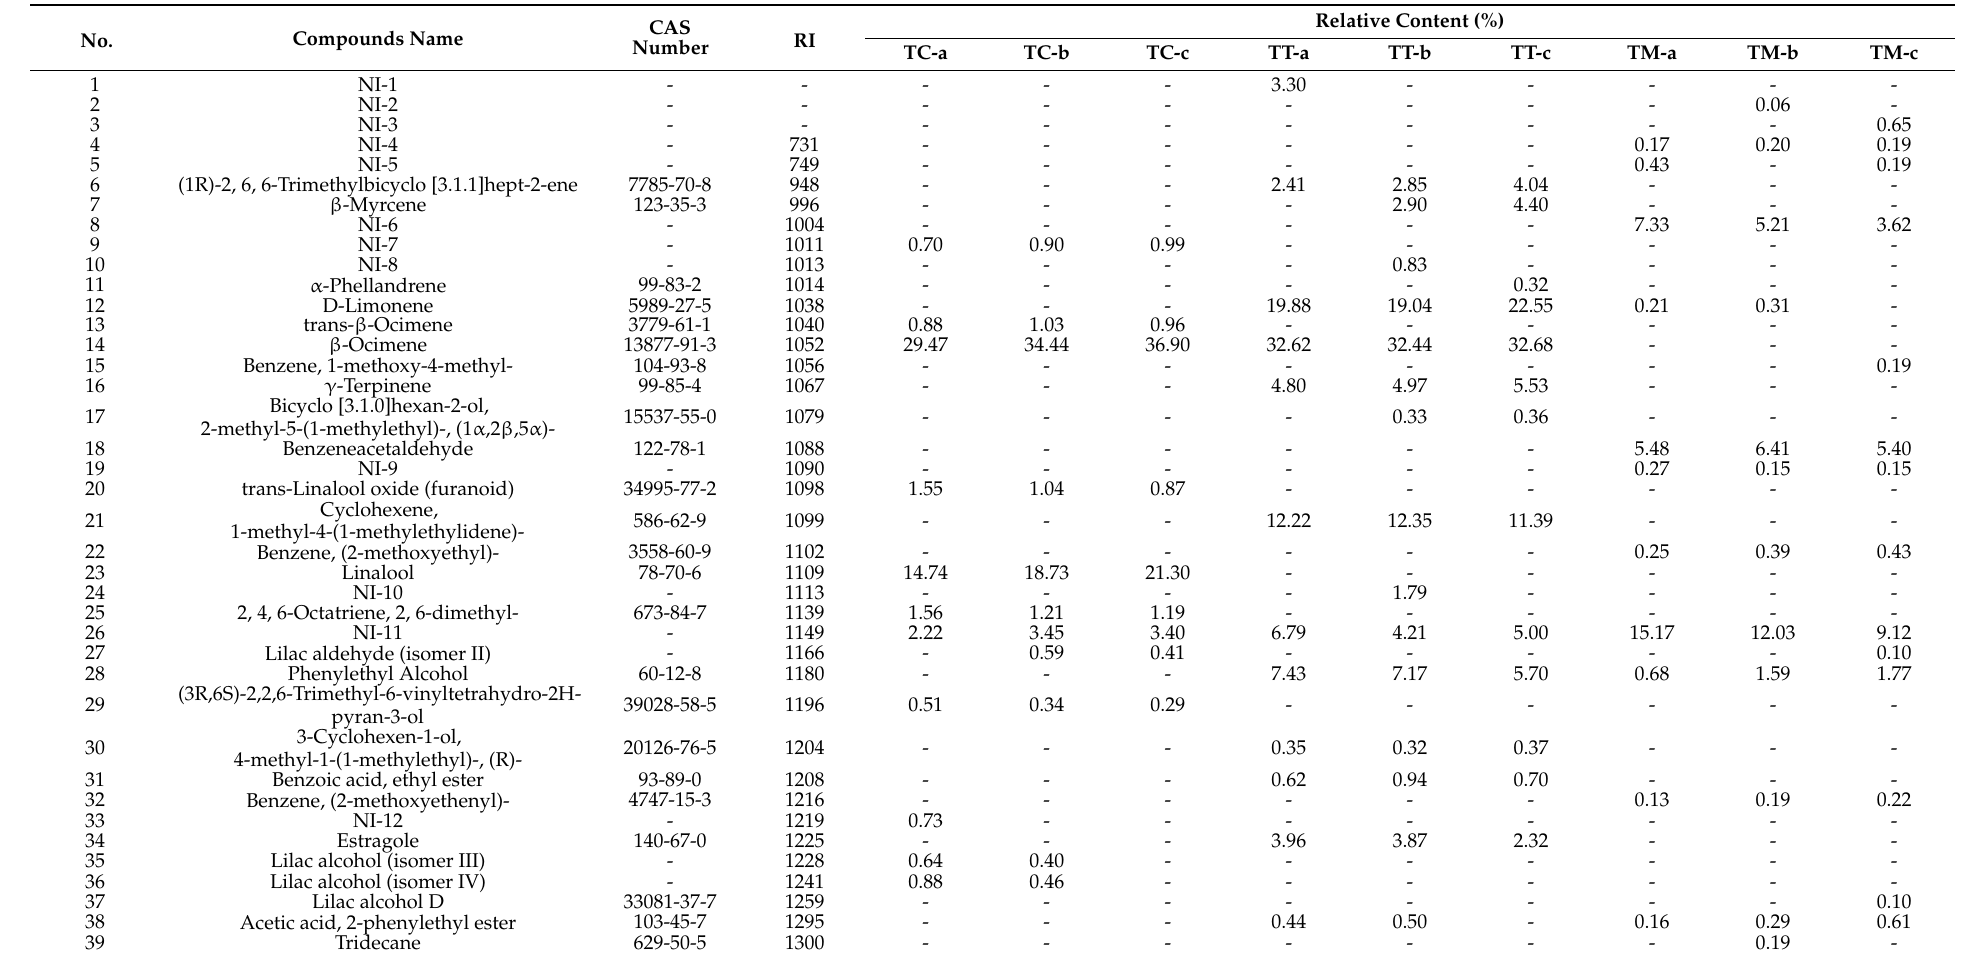
Table 2. Aroma components and relative contents in samples of the three species from Tilia